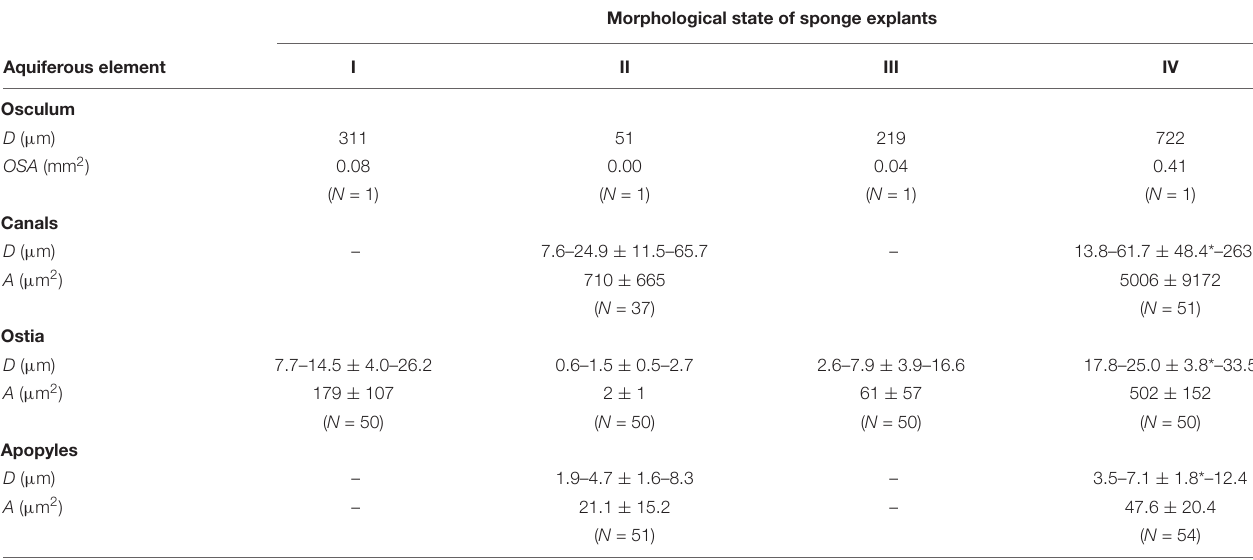
TABLE 5 | Halichondria panicea . Dimensions of aquiferous elements in single-osculum explants in different contractile phases: I, contracting; II, contracted; III, expanding; IV, expanded; measured after fixation for SEM a